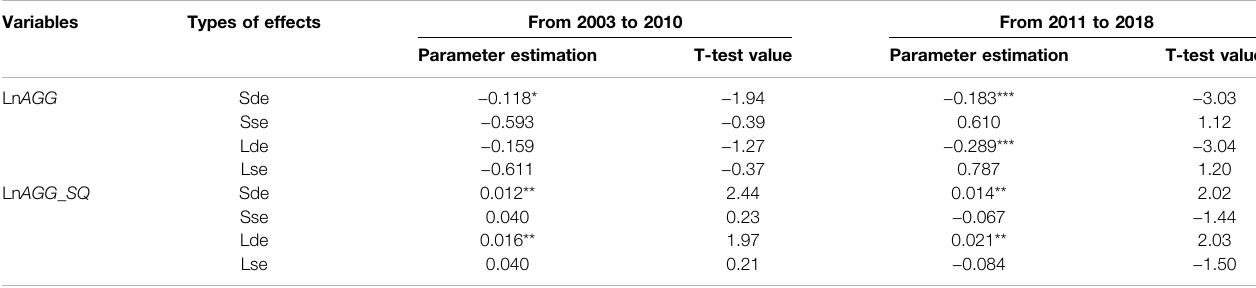
TABLE 9 | Estimated results of the agglomeration by